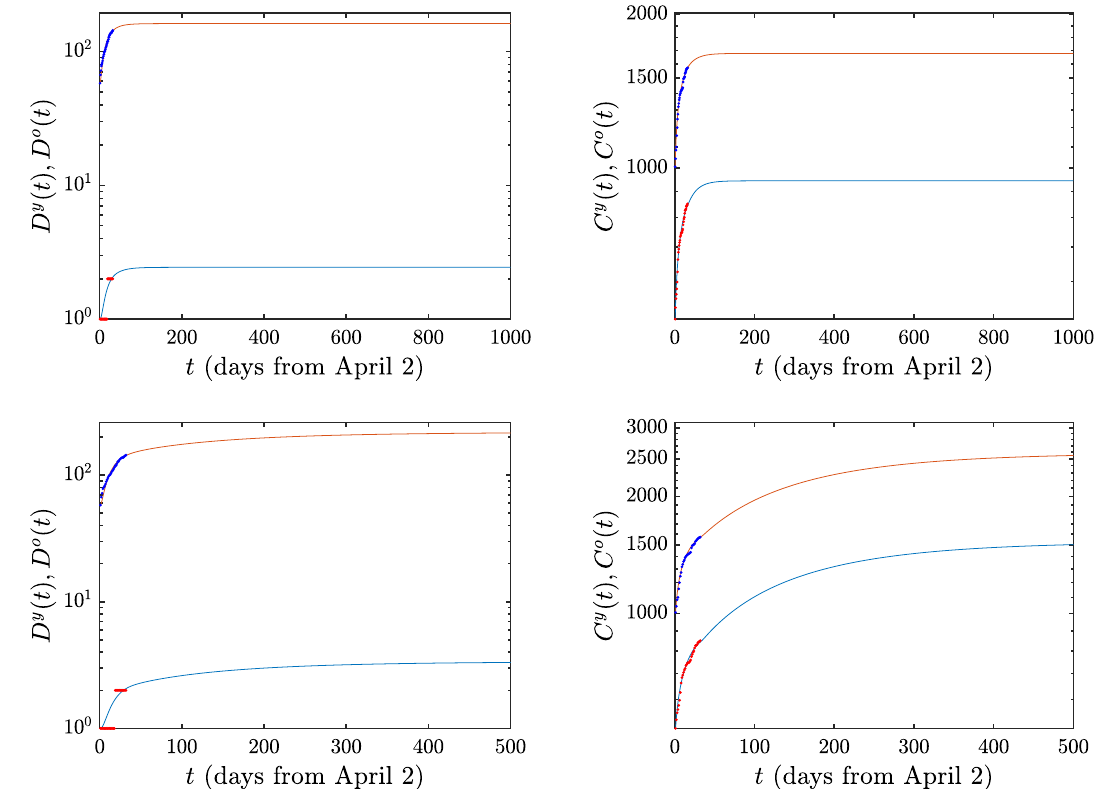
Figure 3. Again the deaths D ( t ) and the cumulative infections C ( t ) are given for the case where the c factor (characterizing the number of contacts) amongst young individuals is doubled, but those of the older individuals (and of the young-older interaction) are kept fixed. This is shown in the top panels. In the bottom panels, the c ’s of both young and old individuals are